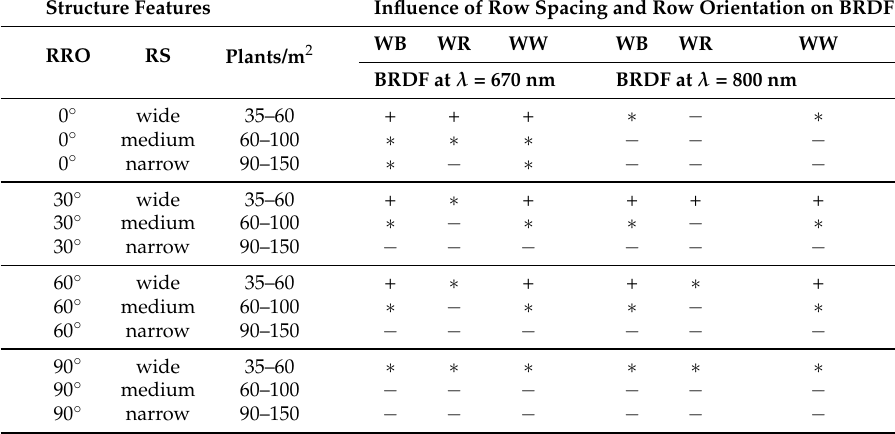
Figure 9. BRDF of winter wheat canopies during early stem elongation at λ = 670 nm and λ = 800 nm for different relative row orientations (RRO = [0 ◦ , 30 ◦ , 60 ◦ , 90 ◦ ]). Table 4. Influence of row spacing (RS) and relative row orientation (RRO) on the BRDF of the different virtual cereal canopies: winter barley (WB), winter rye (WR), winter wheat (WW). Categorised through an automated and visual evaluation of BRDF figures: + the influence of row spacing is automatically measurable; ∗ the influence of row spacing is visually noticeable; and − there is no influence of row spacing noticeable. The different plant density results from the constant number of plants along a plant row for the different row